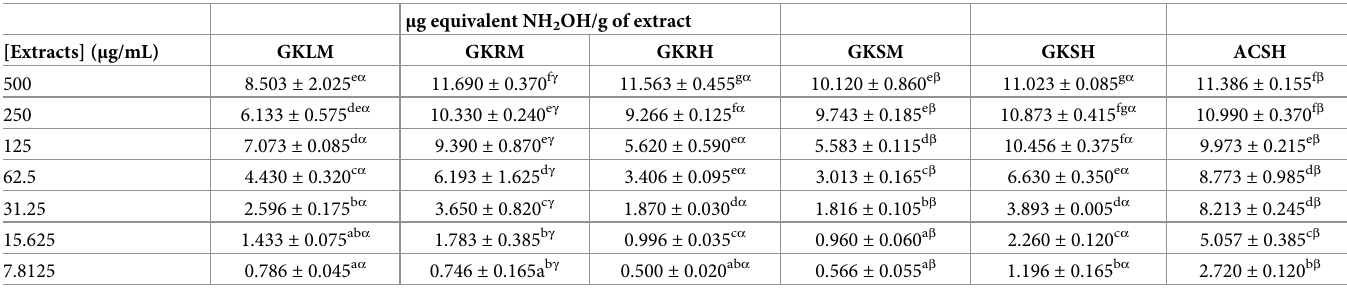
Table 5. Quantitative evaluation of Fe 3+ reducing power by crude extracts of G . kola and A . cordifolia